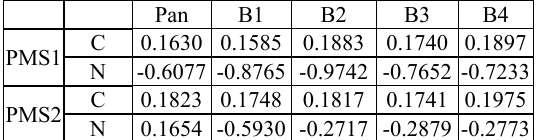
Table 1. A and N parameters for Gaofen-2 sensors